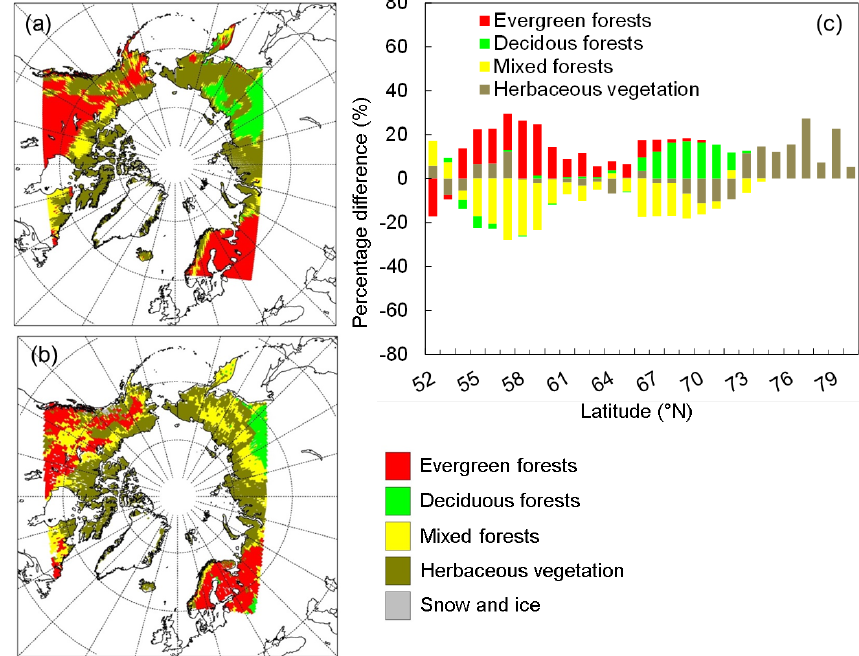
Figure 4. The dominant potential natural vegetation (PNV) distribution comparison for the recent period. (a) The tile-weighted PNV sim- ulated by RCA-GUESS for the period 1961–1990. (b) The validation map derived from the ISLSCP II Potential Natural Vegetation Cover data set (Ramankutty and Foley, 2010) and the Kaplan PNV map (Kaplan et al., 2003). (c) Percentage difference (simulated minus validation map) between the number of grid cells each aggregated vegetation class occupies in each latitude band, from 52–80 ◦